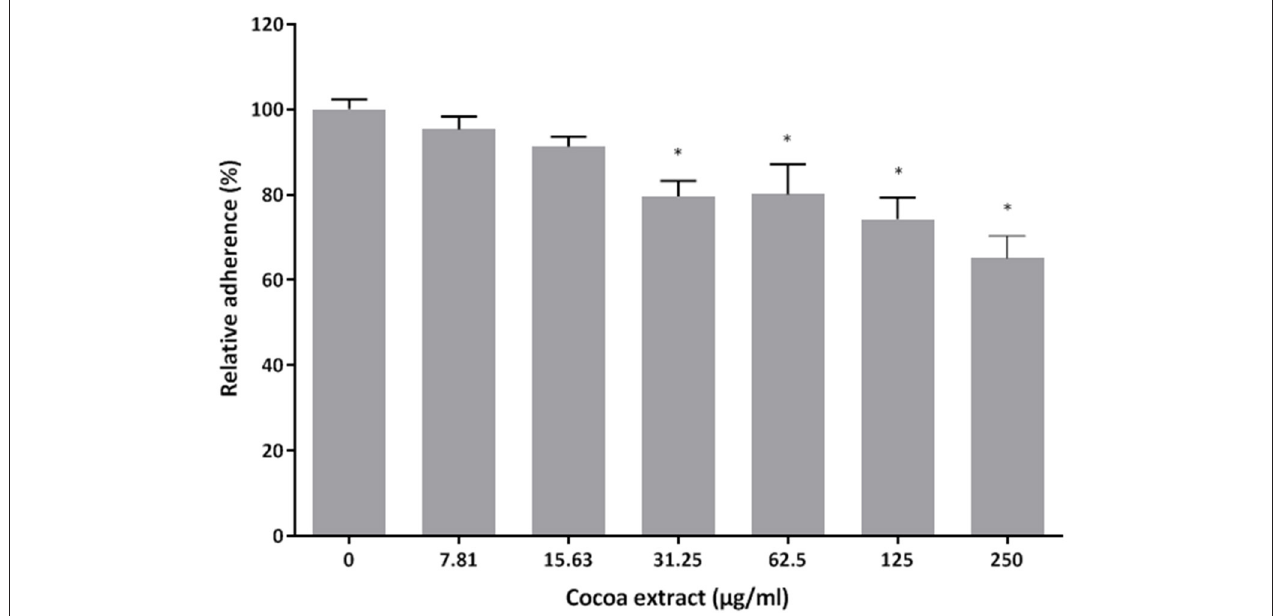
FIGURE 6 | Effect of the cocoa extract on the adherence of P. gingivalis to the Matrigel TM basement membrane model. Adherence of FITC-labeled bacteria was monitored by recording the fluorescence at excitation and emission wavelengths of 495 and 525nm, respectively, following a 2-h incubation. A relative value of 100% was assigned to the adherence obtained in the absence of the cocoa extract. *significant inhibition ( p < 0.01) compared to the control (no cocoa extract).